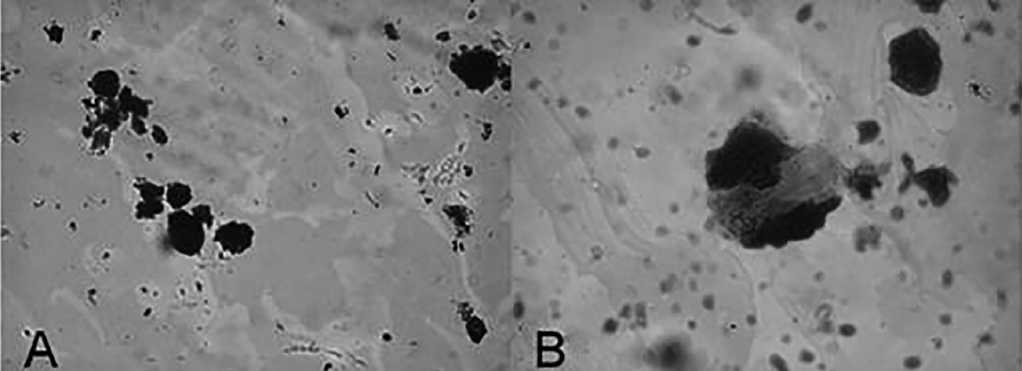
FIGURE 1 - A sample of powder of divided seeds viewed using an optical microscope at 400x. Phenolic compounds (A) and mucilages (B) are